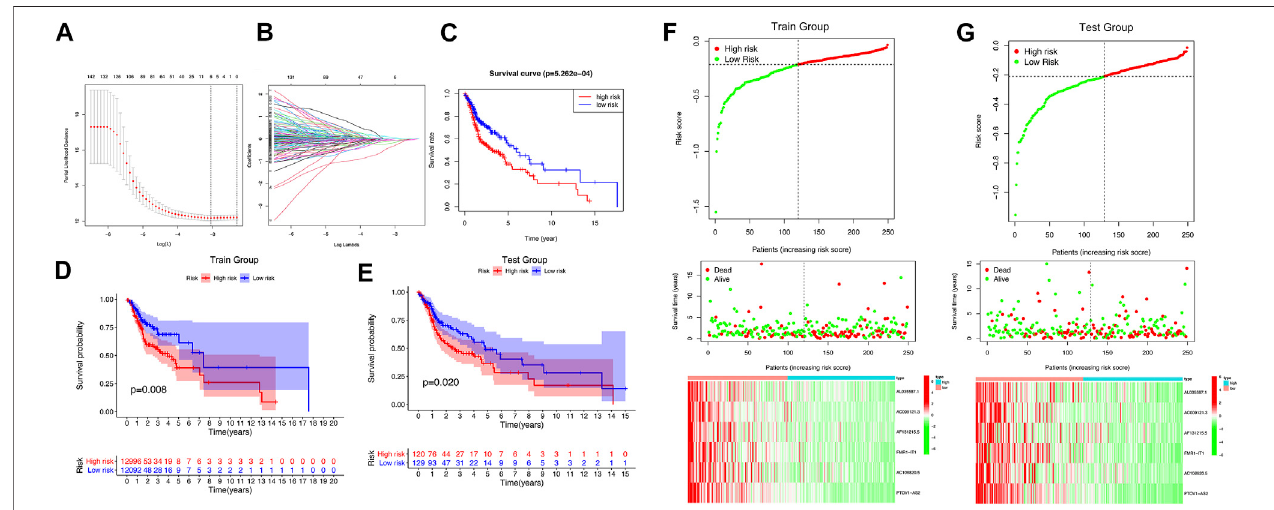
FIGURE 4 | The m 6 A/m 5 C/m 1 A-related lncRNAs Prognostic signature. (A,B) 6 m 6 A/m 5 C/m 1 A-related lncRNAs were found by using least absolute shrinkage and selectionoperator(LASSO)coxregression. (C) Kaplan-Meiercurveofoverallsurvivalofhigh-riskgroupandlow-riskgroup. (D,E) Kaplan-Meiercurveofoverallsurvivalof train group and test group. (F,G) The distribution of risk score, survival status and m 6 A/m 5 C/m 1 A-related lncRNAs expression panal.